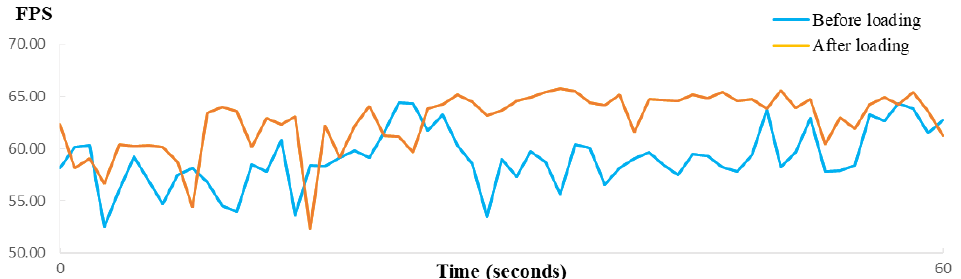
Figure 14. Average frames per second (FPS) before and after loading for experimental area 1.